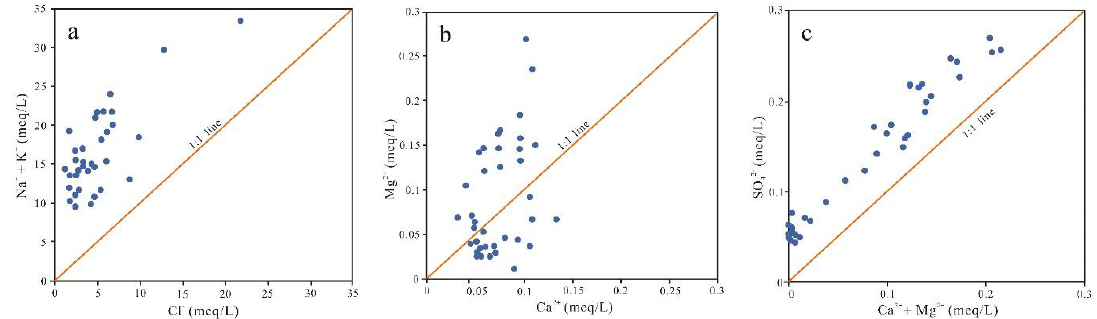
Figure 3. Relationship between hydrochemical characteristics in the Shizhuangnan block: ( a ) K + + Na + versus Cl − ; ( b ) Mg 2+ versus Ca 2+ ; ( c ) SO 42 − versus Ca 2+ + Mg 2+ .